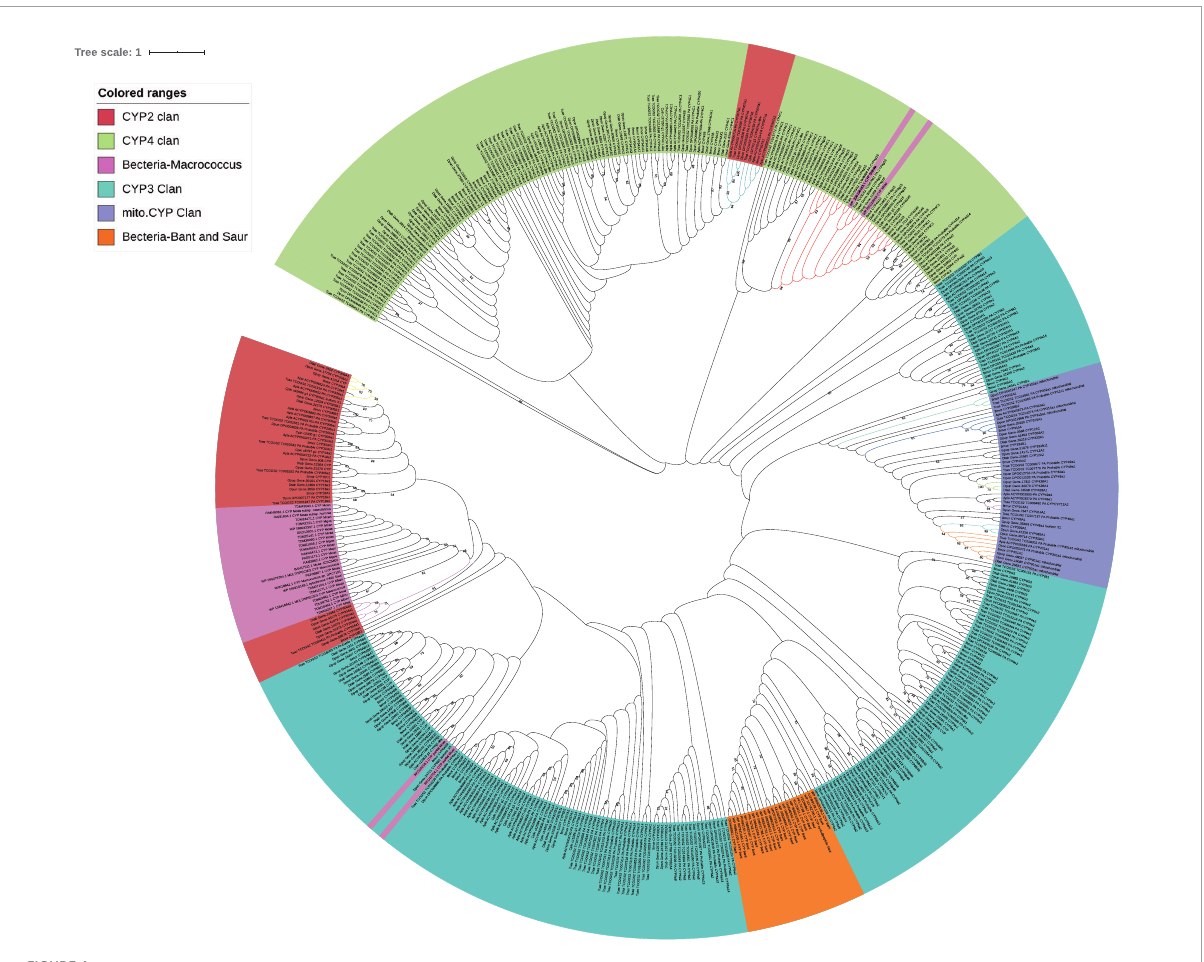
FIGURE4 Maximum-likelihood phylogram of cytochrome P450 based on five conserved domains in eight insects ( Gastropacha populifolia , Dendrolimus punctatus , Dendrolimus tabulaeformis , Bombyx mori , Acyrthosiphon pisum , Cinara pinitabulaeformis , Tribolium castaneum , and Dendroctonus ponderosae ) and bacteria ( Macrococcus caseolyticus, Staphylococcus aureus, and Bacillus anthracis ). The bootstrap values above 50 (1,000 replicates) are shown. Ten co-orthologous groups are marked with different line colors.